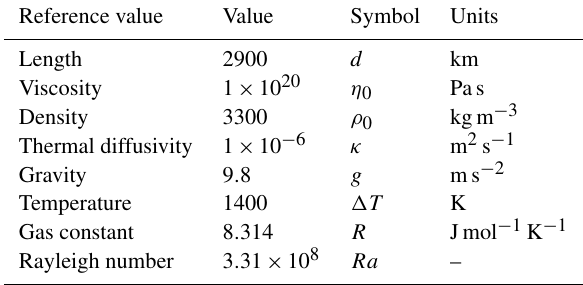
Table A1. Reference values used to non-dimensionalize the Stokes and energy equations, as described in Appendix A.